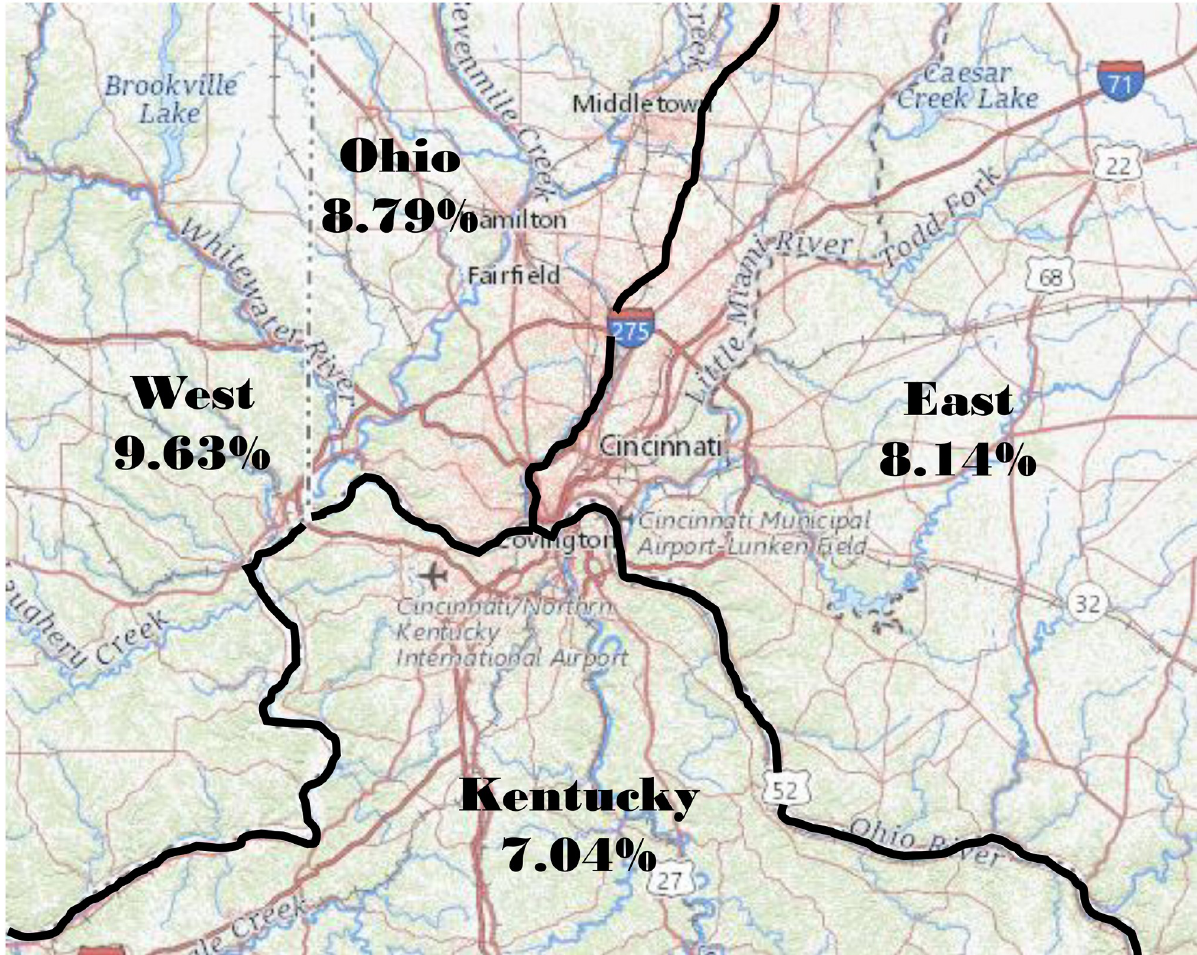
Fig 3. Seroprevalence of Spike protein ELISA positivity in the Greater Cincinnati Metropolitan Area. Map image courtesy of the Unites States Geological Survey (USGS) National Map Viewer (public domain: https://apps.nationalmap.gov/viewer/). The Greater Cincinnati Metropolitan Area (GCMA) shown as defined by the United States Census Bureau (https://data.census.gov/cedsci/map?q=All%20counties%20in%20Ohio&g= 310M500US17140&tid=ACSDP5Y2019.DP02&layer=VT_2019_310_M5_PY_D1&cid=DP02_0093PE&palette=Teal&break=5&classification=Natural %20Breaks&mode=customize) and reported in the 2010 AGE, RACIAL, GENDER AND MARITAL STRUCTURE OF GREATER CINCINNATI. The Cincinnati Metropolitan Statistical Area (MSA) includes: Butler, Brown, Clermont, Hamilton, and Warren Counties in Ohio; Boone, Bracken, Campbell, Gallatin, Grant, Kenton, and Pendleton Counties in Kentucky; and Dearborn, Franklin, and Ohio Counties in Indiana.